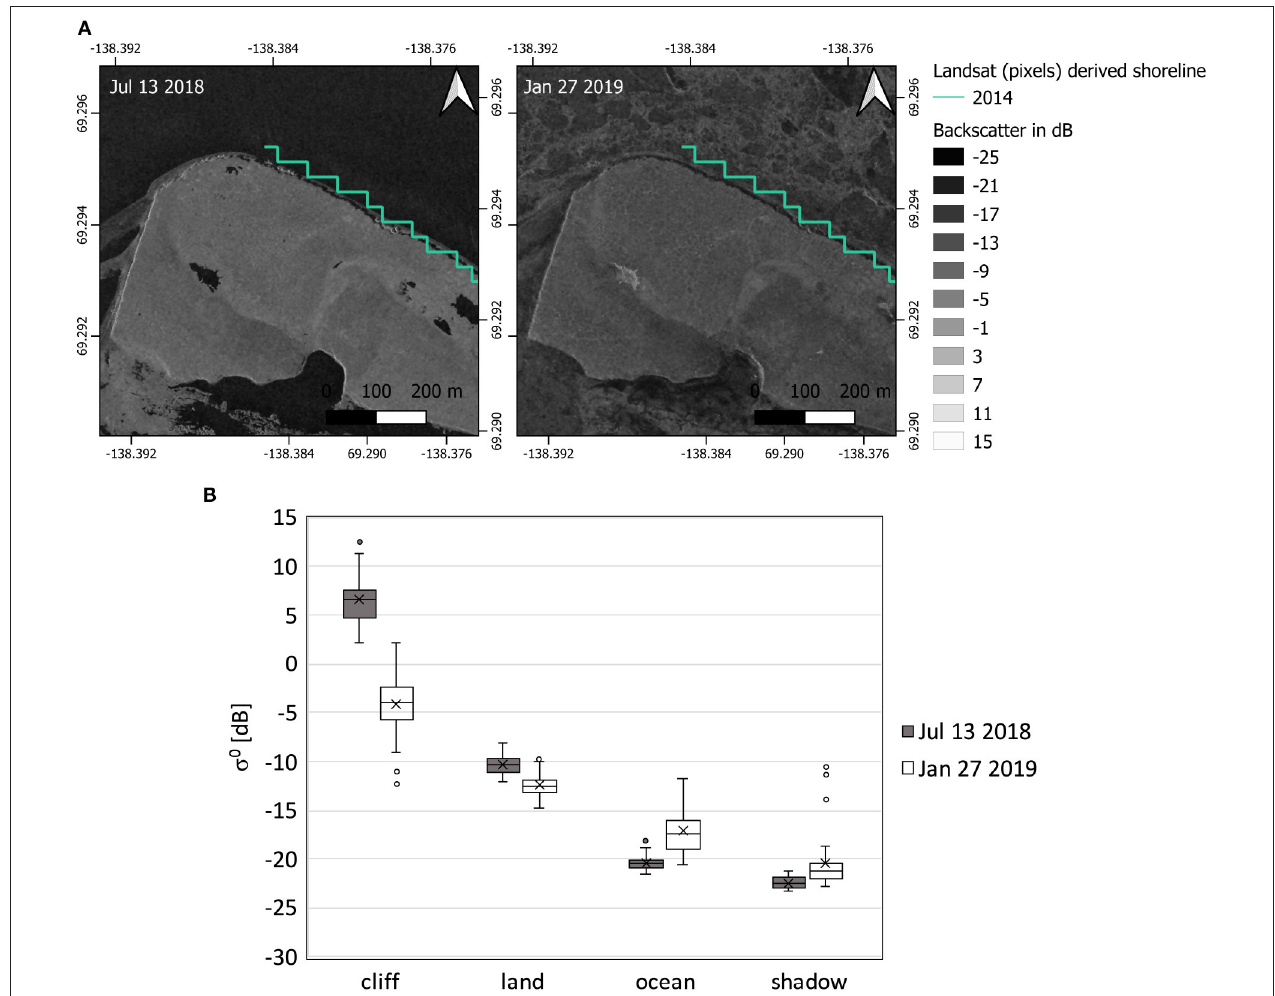
FIGURE 4 | Backscatter characteristics ( σ 0 in dB) of TerraSAR-X at Kay Point: (A) Example of a summer and a winter acquisition including the Landsat derived coastline for demarcation of the analysed coast segment (using) trend data based on probability of land to water change between 1999 and 2014 ( Nitze et al., 2018); visualization based on vectorized 30 × 30 m pixels), (B) boxplots of backscatter samples for all relevant classes (cliffs facing toward the sensor, land, ocean, and radar shadow) at 40 degree incidence angle for summer and winter.